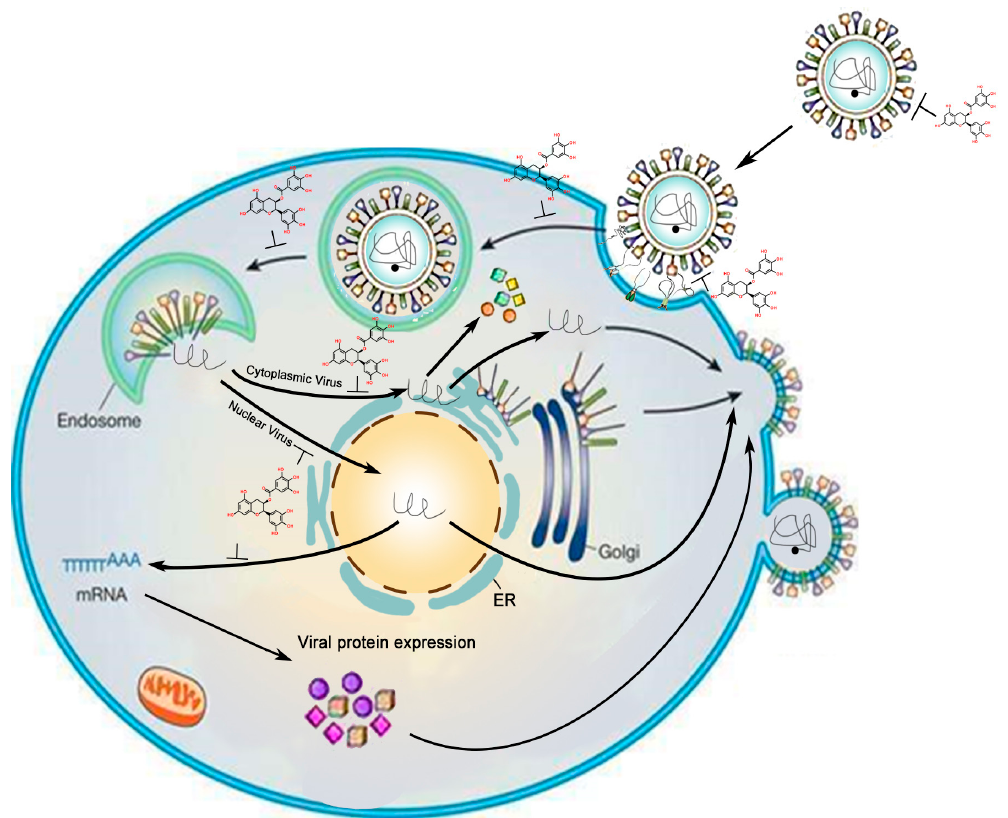
Figure 2. Inhibitory effects of EGCG against viruses at different stages of viral invasion. In this figure, to summarize many different viruses and models, according to the genome replication (omitting the type of nucleic acid), the viruses are divided into two types: nuclear virus and cytoplasmic virus. The symbol “ ⊥ ” indicates the sites of GTC functions its antiviral effects.